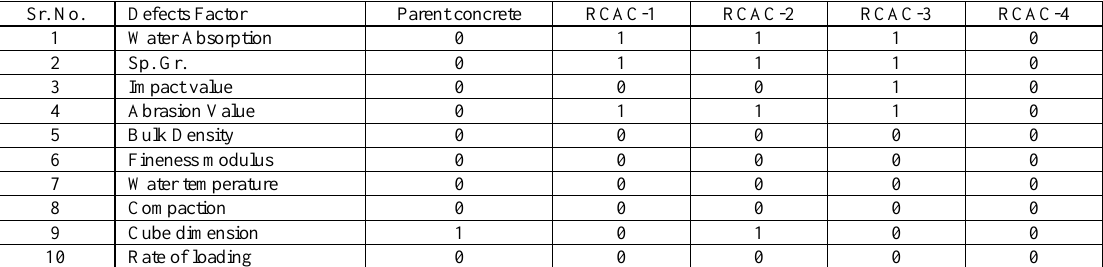
Table 7. Defects in process and raw